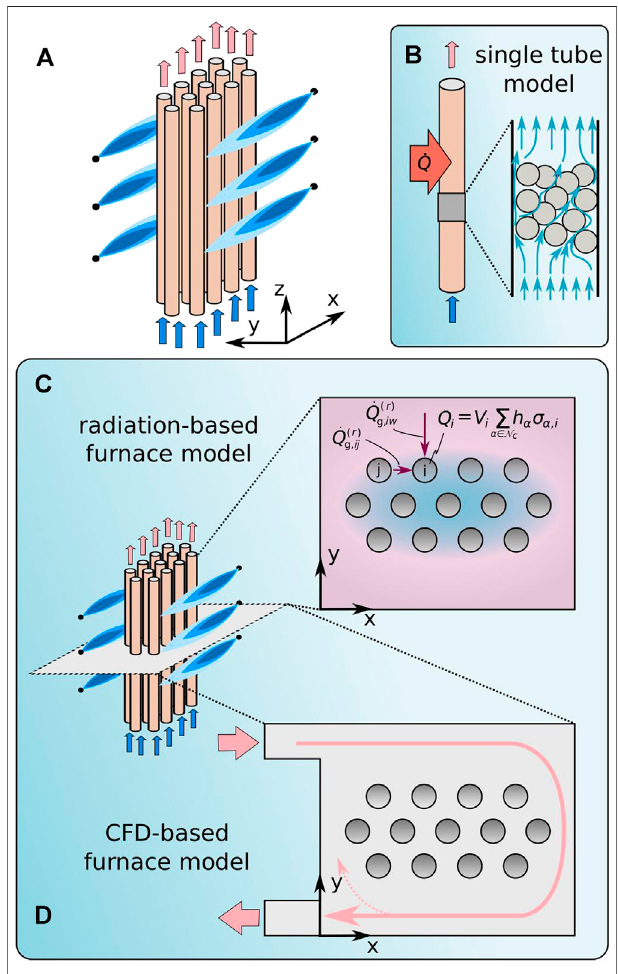
FIGURE 1 | Sketch of a side- fi red tube bundle furnace (A) and three differentmodels:thesingletubemodel (B) ,theradiation-basedfurnacemodel (C) , and the CFD-based furnace model (D)